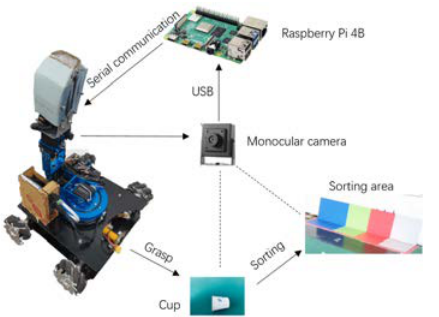
Fig. 2. Overall system